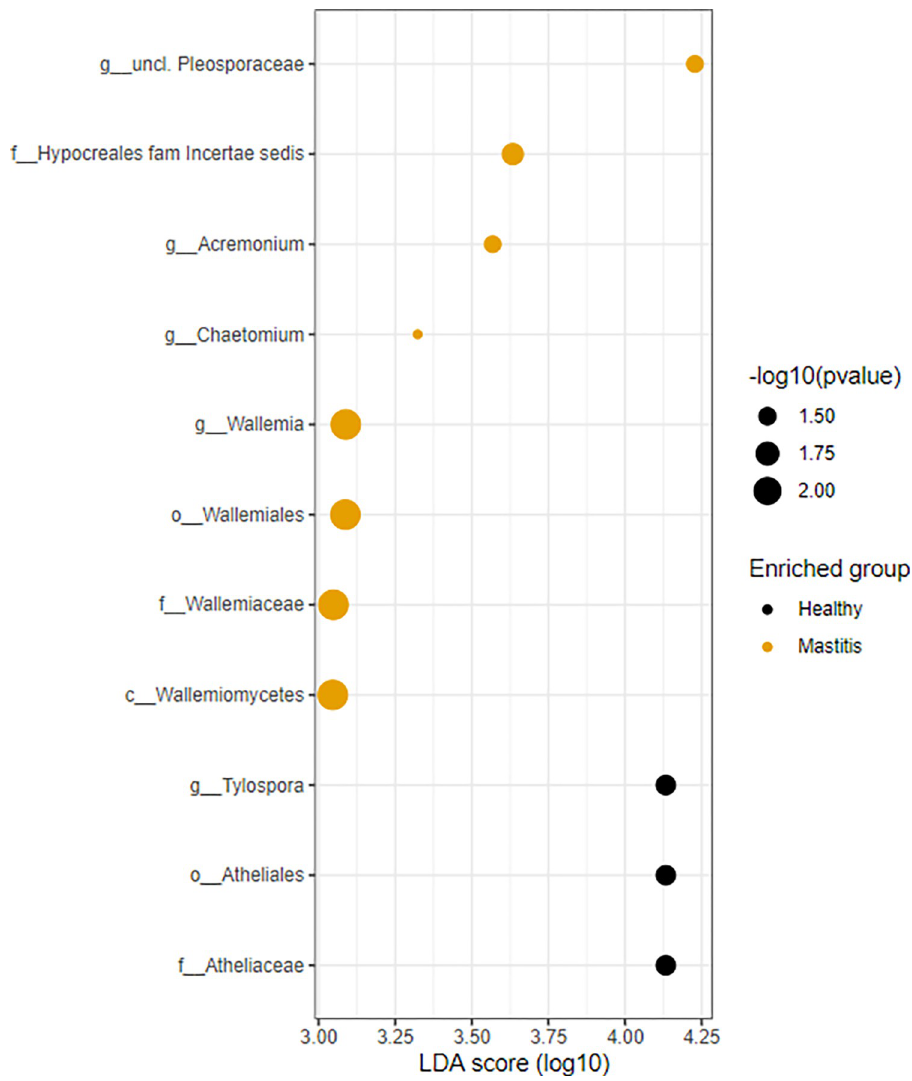
Fig 7. Effect size and statistical significance of the top ten marker per sample group corresponding to healthy and mastitis samples for the